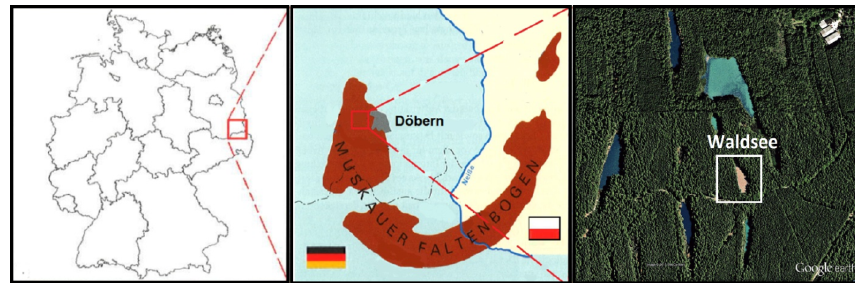
Figure 1. Geographical location of Waldsee within the Muskau Arch in eastern Germany (after Kozma and Kupetz,